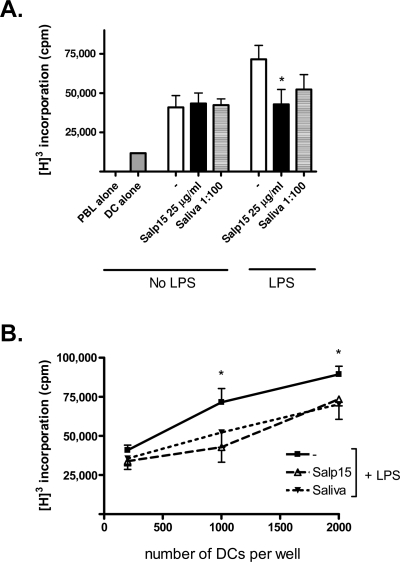
Salp15 Inhibits DC-Induced T Cell Proliferation(A and B) Salp15 impairs DCs in the induction of T cell proliferation as shown by a mixed lymphocyte reaction (MLR). After 18 h of stimulation with LPS in the presence of Salp15 (25 μg/ml), tick saliva (1:100), or controls, DCs were extensively washed and cultured with allogeneic PBLs (1 × 105) at different ratios (1:50 to 1:500) for 4 d. Lymphocyte proliferation was assessed by overnight incorporation of radioactive thymidine. Data are representative of results obtained from four donors. Bars represent the mean of triplicates within one experiment ± SE. Differences between the different conditions were analyzed by a two-sided one way ANOVA, implementing a one way analysis of variance with Dunnett multiple comparison test. A p-value < 0.05 was considered statistically significant and indicated with one asterisk (*).